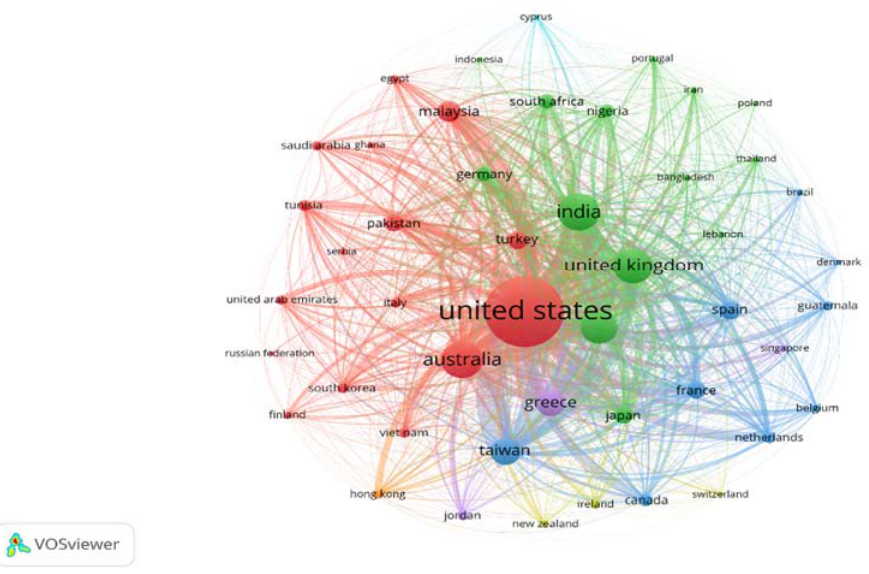
Figure 8. Bibliographic coupling of countries. Source: Elaborated by authors using data extracted from